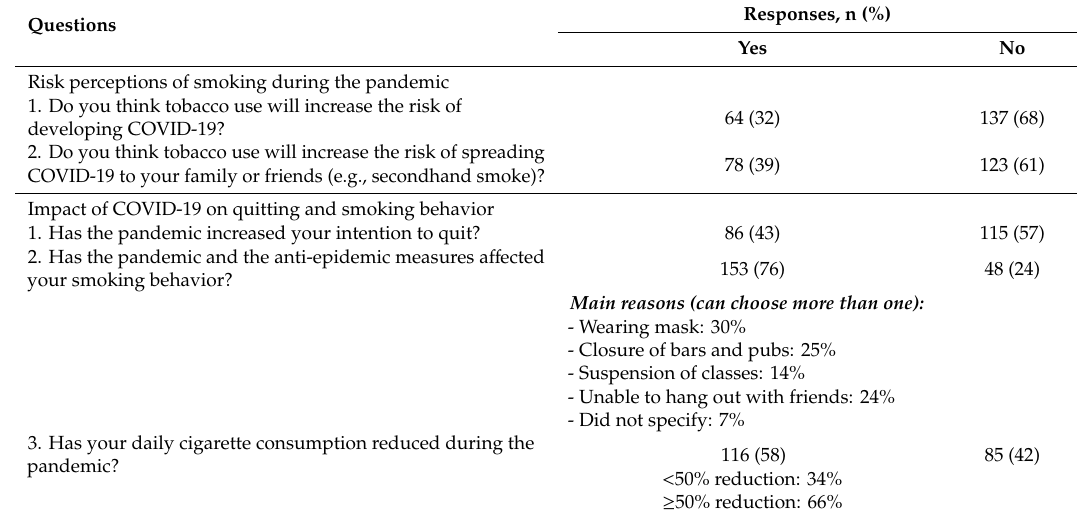
Table 1. Young smokers’ quitting and smoking behavior, and their risk perceptions of smoking during the pandemic (N =